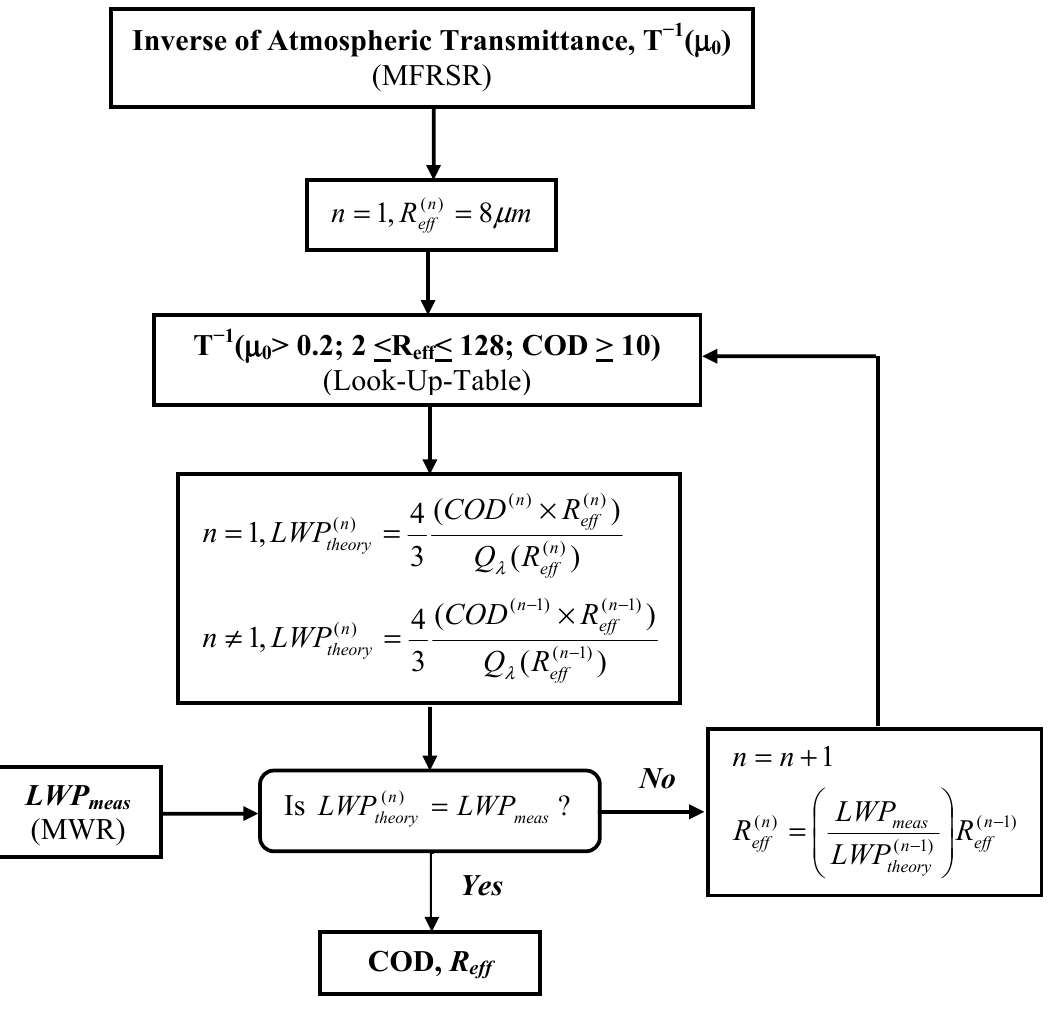
Figure 6. Schematic illustration of the algorithm flow for the LUT based iterative approach for retrieving cloud optical properties of thick water clouds. Here cloud liquid water path (LWP ) represents the real-time instantaneous liquid water path measurement meas from MWR and the order (or number) of iteration is denoted by “n” as subscript to the variable